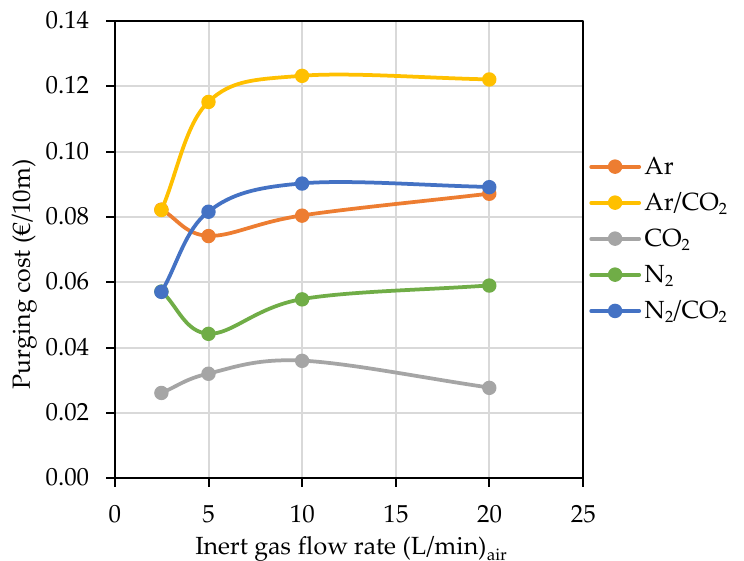
Figure 12. Comparison of inerting cost (€) for 10 m length hose of IIR with the tested inert gases at a different flow rate.